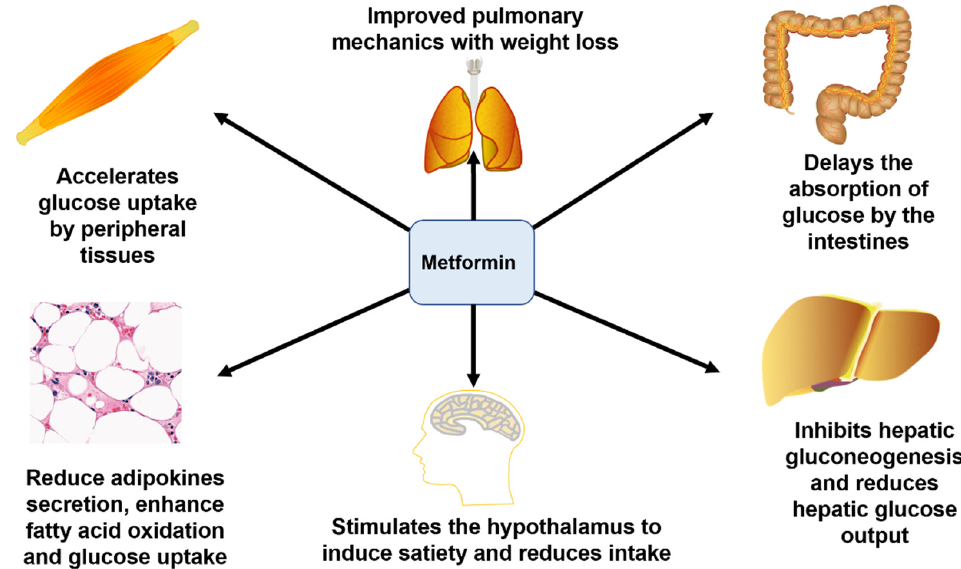
Figure 1. Mechanism of the function of metformin in the treatment of T2DM.